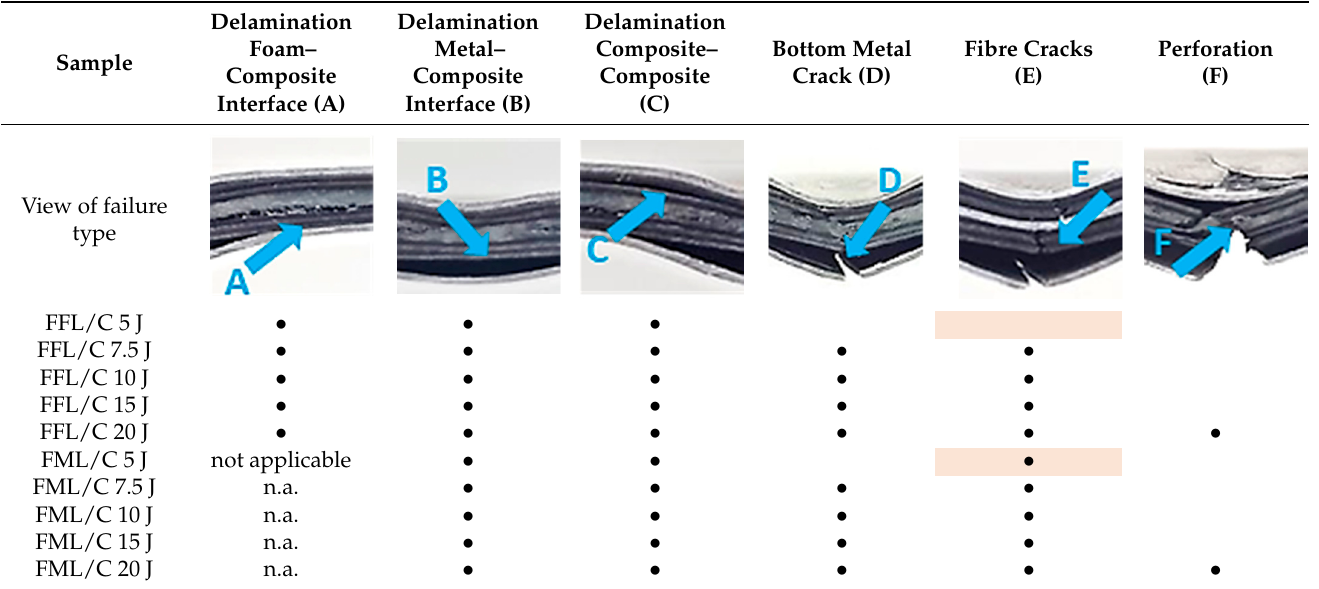
Table 2. Types of failure in carbon–based laminates.